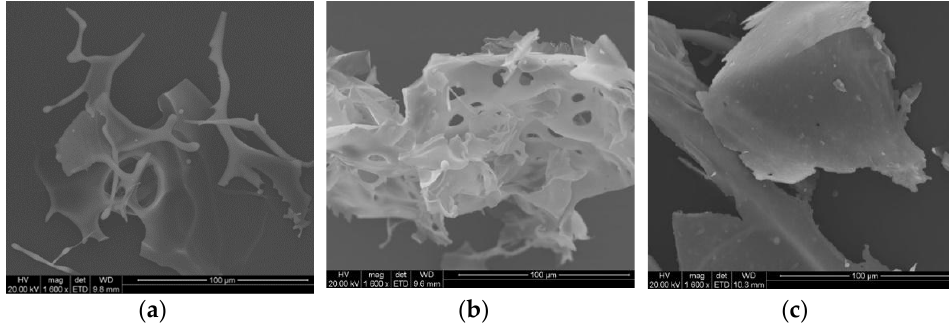
Figure 2. SEM images of ( a ) fd_S, ( b ) fd_ST and ( c ) fd_SM. Magnification 1600×. The sd_S and sd_SMT powders were made up of microparticles characterized by rough surfaces, with hollows and wrinkles due to the partial collapse of the particles [55].